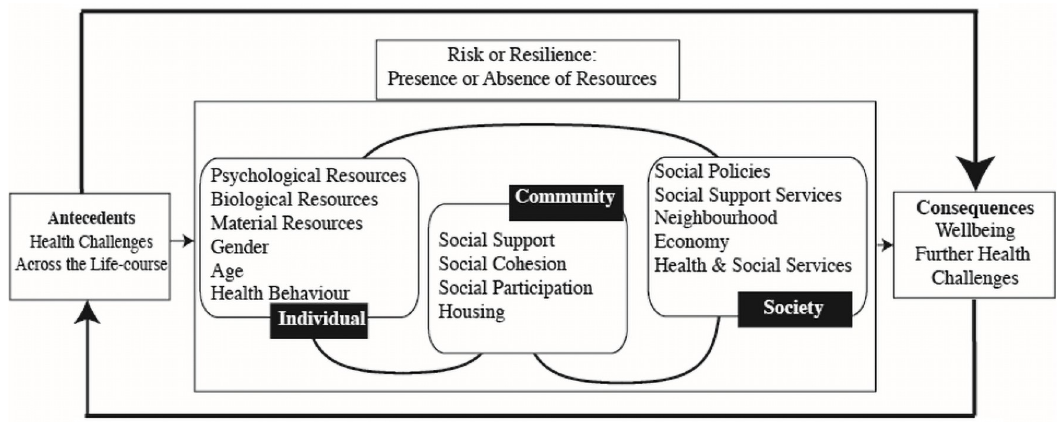
Fig 1. The ecological model of resilience adapted from Windle and Bennett